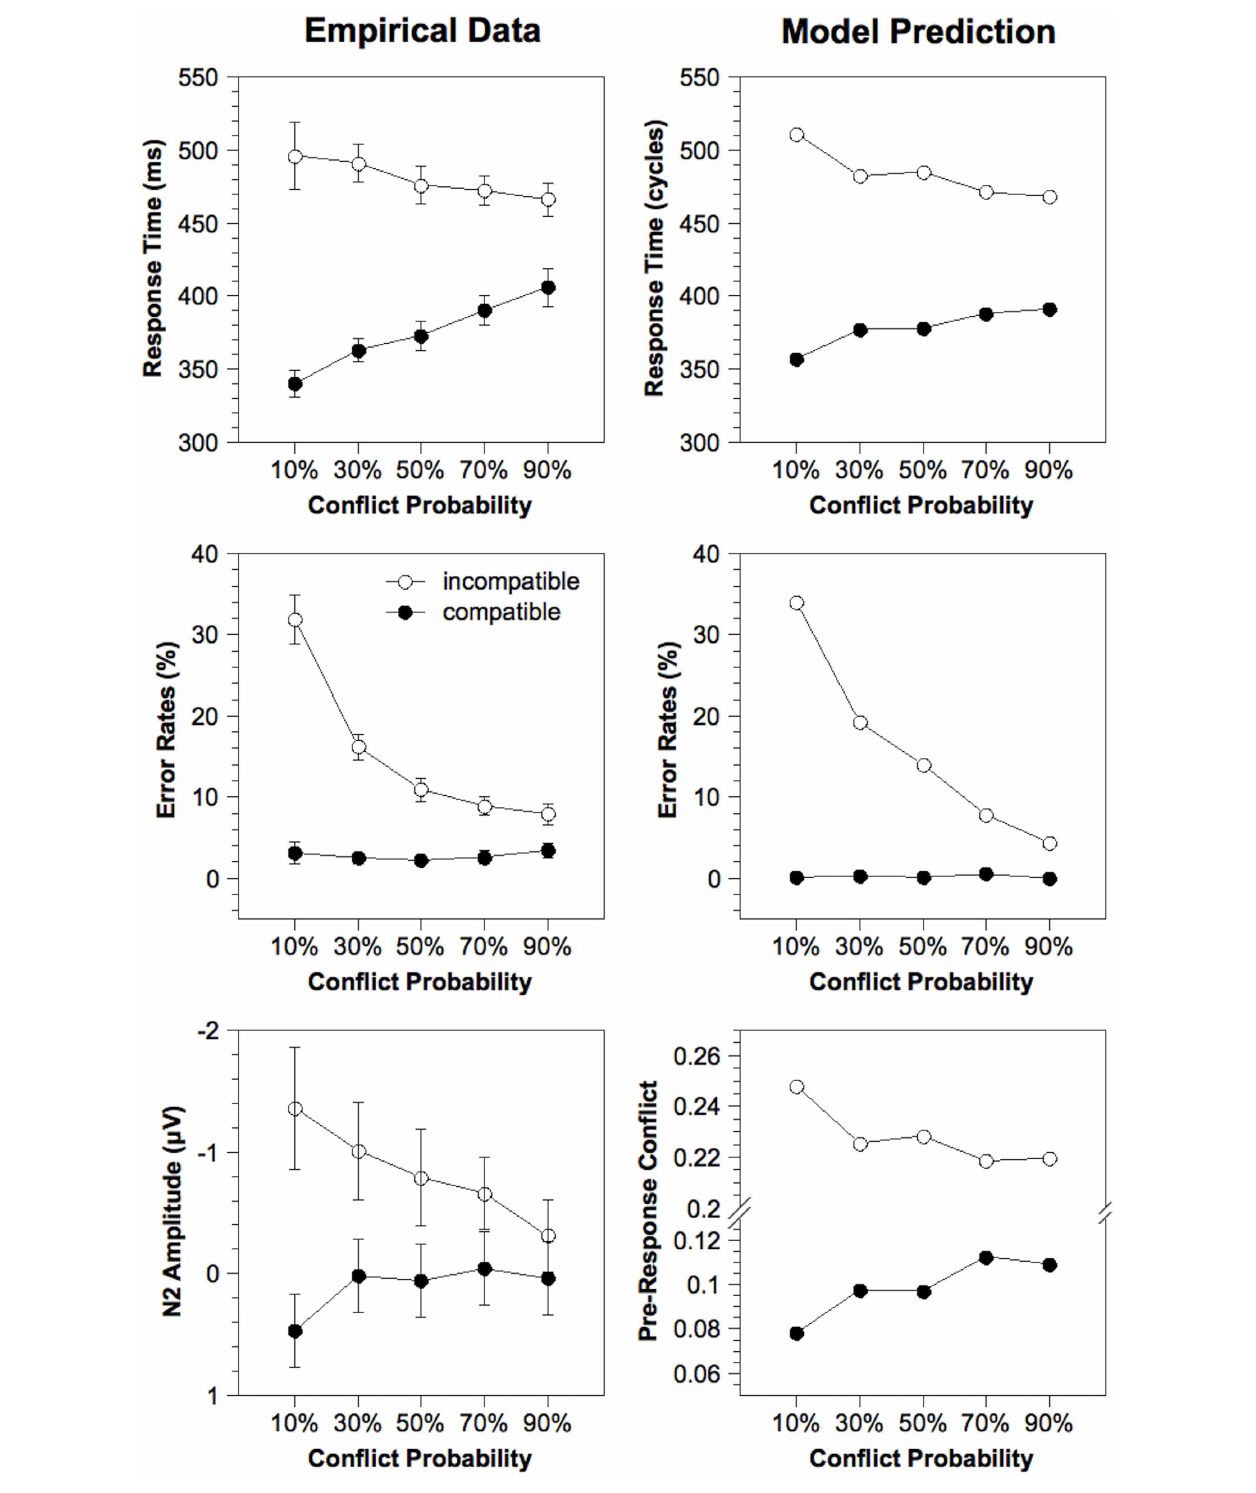
Note that the results for the alternative model variants are approximately the same because these model differ only with respect to the order of ext C (t) values within each condition, which does not influence the averaged results. ms,